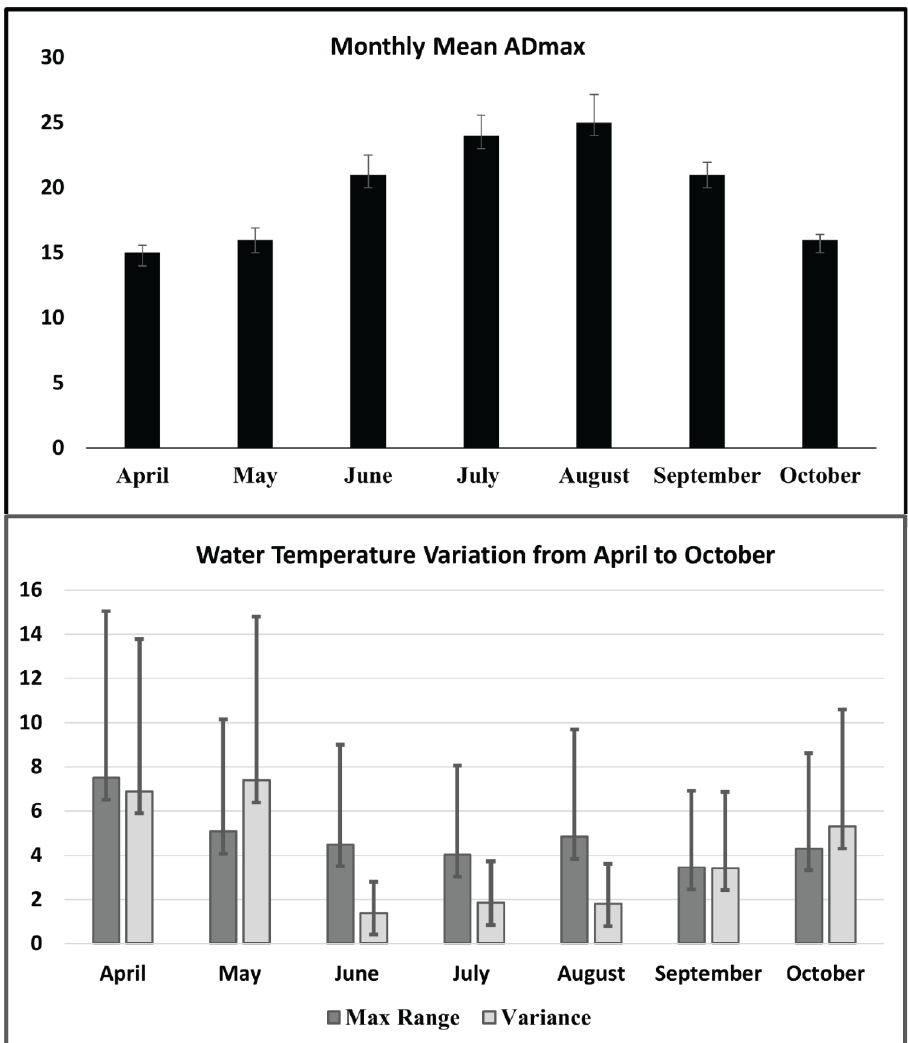
Figure 5. Monthly magnitude of change and variability per month for April to October. The monthly mean ADMax, maximum range of water temperature per month, and variance of mean daily water temperature per month and standard deviation values are shown.